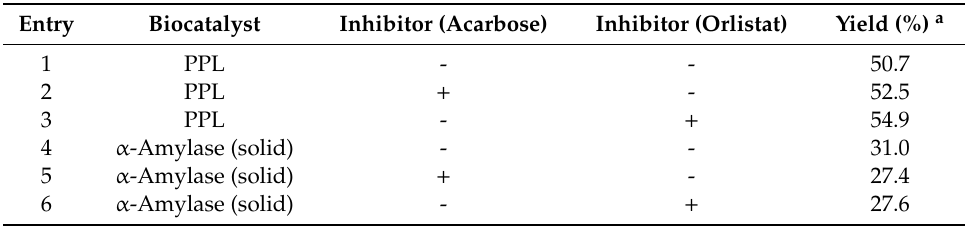
Table 6. Addition of catalyst